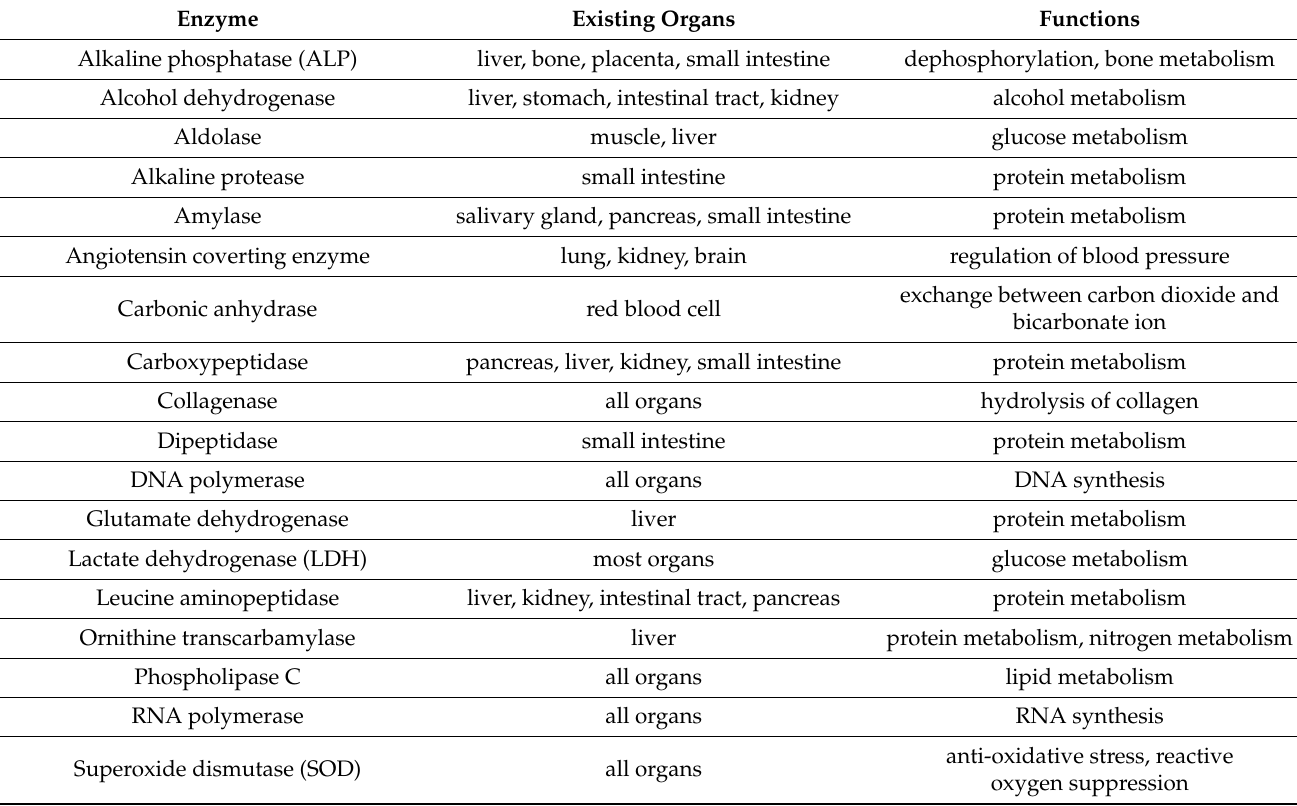
Table 1. Main enzymes containing zinc, existing organs, and their